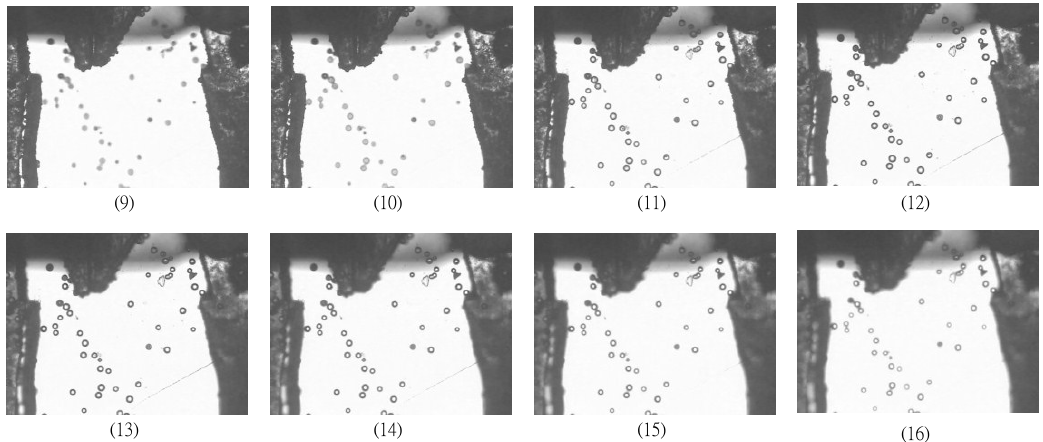
Figure 4. A sequence of eight images from total 29 images are displayed to illustrate the test of autofocusing functions. Images ( 1 )–( 12 ) are captured in the focusing process while Images ( 13 )–( 29 ) are captured in the defocusing process. Note that the best focusing image is at Image ( 12 ).